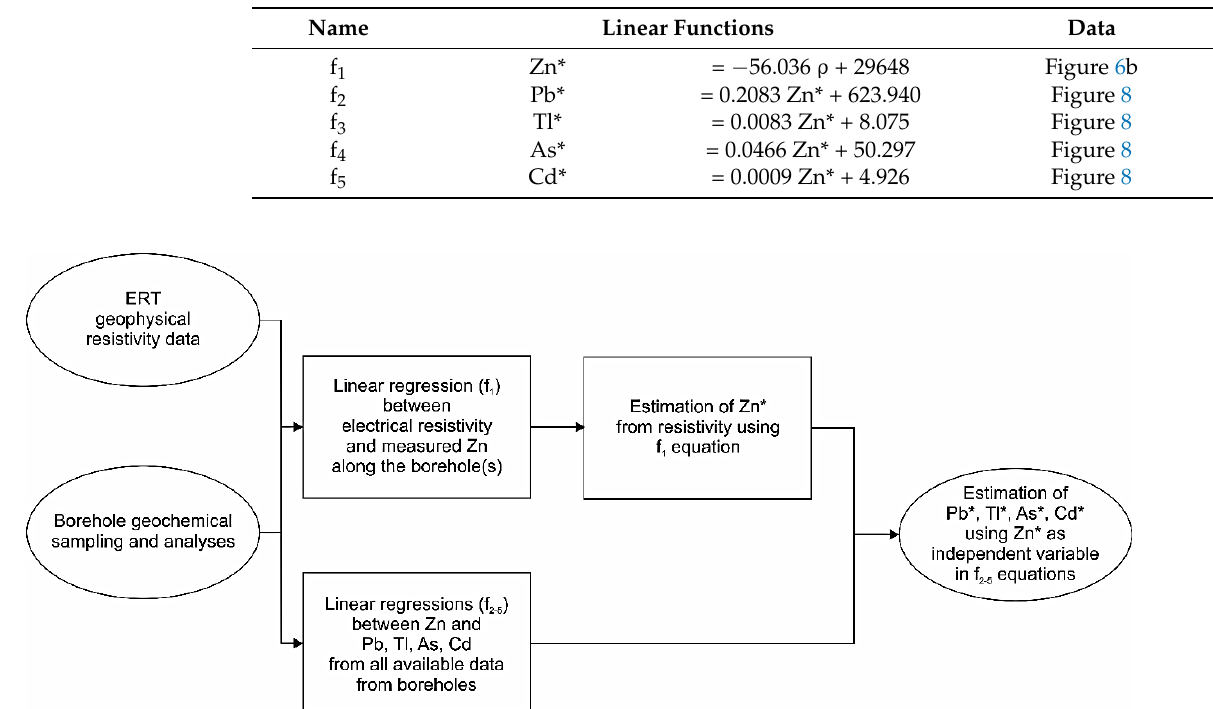
Figure 7. Flux diagram of the procedure for the estimation of metal content. For f n meaning refer to the equations reported in Table 3 and ERT as “Electrical Resistivity Tomography” technique. The notation “*” indicates the estimated metal(oid) concentrations.